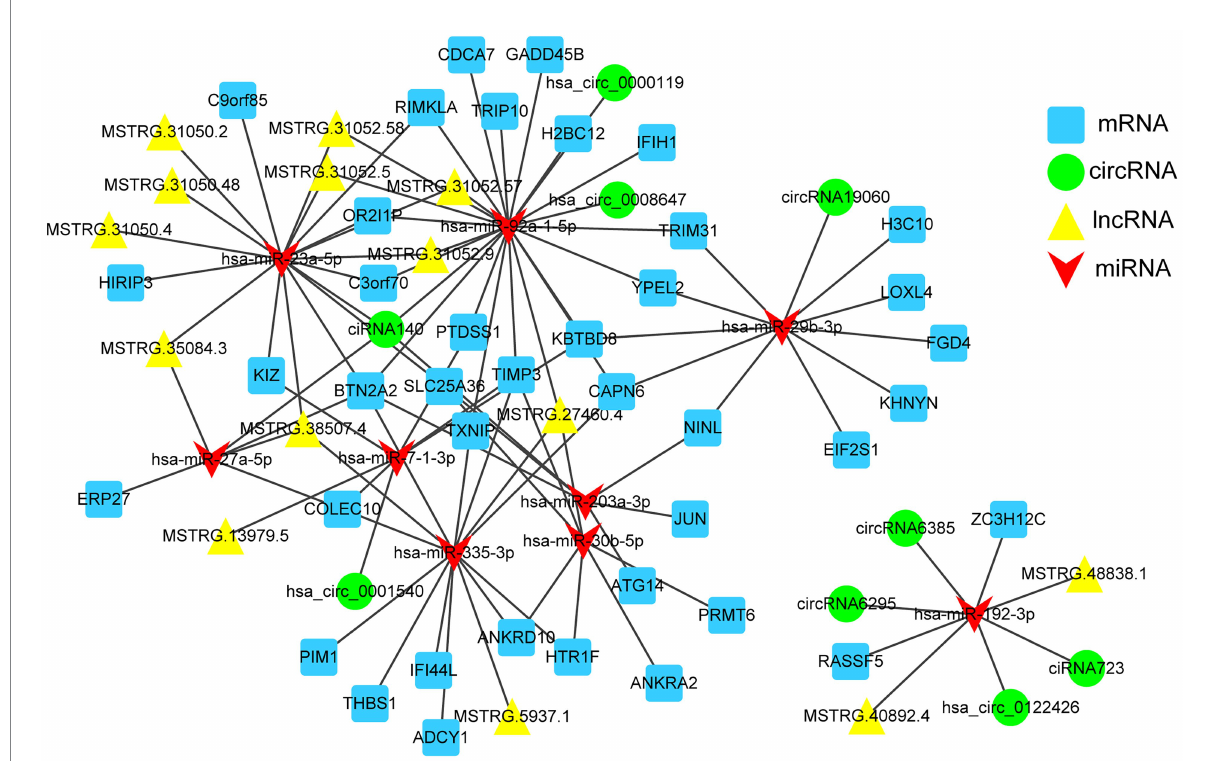
FIGURE 7 The competing endogenous RNA (ceRNA) network. mRNAs, circRNAs, host lncRNAs and miRNAs in the networks are represented as squares, circles, triangles and arrows, respectively.